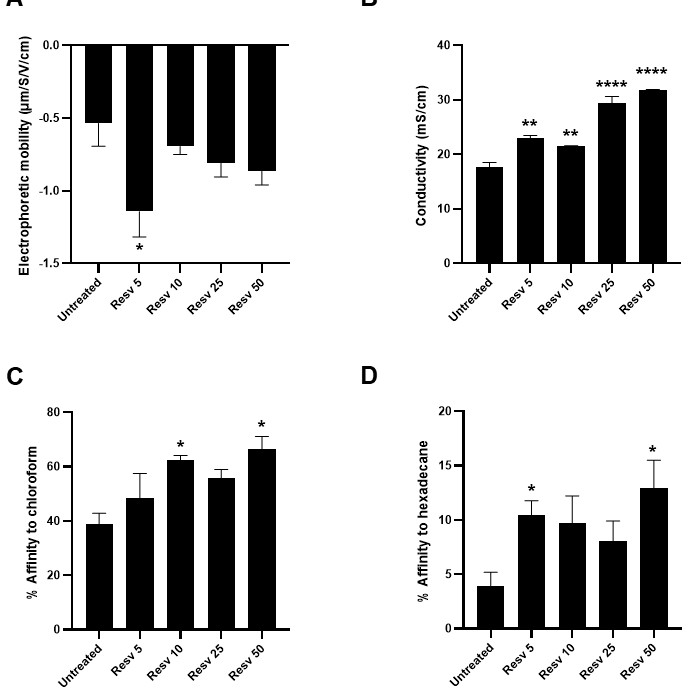
Figure 4. Resveratrol changed physico-chemical surface properties of L. paracasei ATCC334 strain. ( A ) Electrophoretic mobility of L. paracasei in absence (untreated) or presence of increasing doses of Resveratrol, from 5 µ M (Resv 5) to 50 µ M (Resv 50). Values (in µ m / S / V / cm) represent mean ± SEM of at least five separate measures. ( B ) Measure of conductivity of L. paracasei in absence (untreated) or presence of increasing doses of Resveratrol, from 5 µ M (Resv 5) to 50 µ M (Resv 50). Values (in µ m / S / V / cm) represent mean ± SEM of at least five separate measures. ( C ) MATS test, the percentage of adhesion of L. paracasei, in the absence (untreated) or presence of increasing doses of Resveratrol,